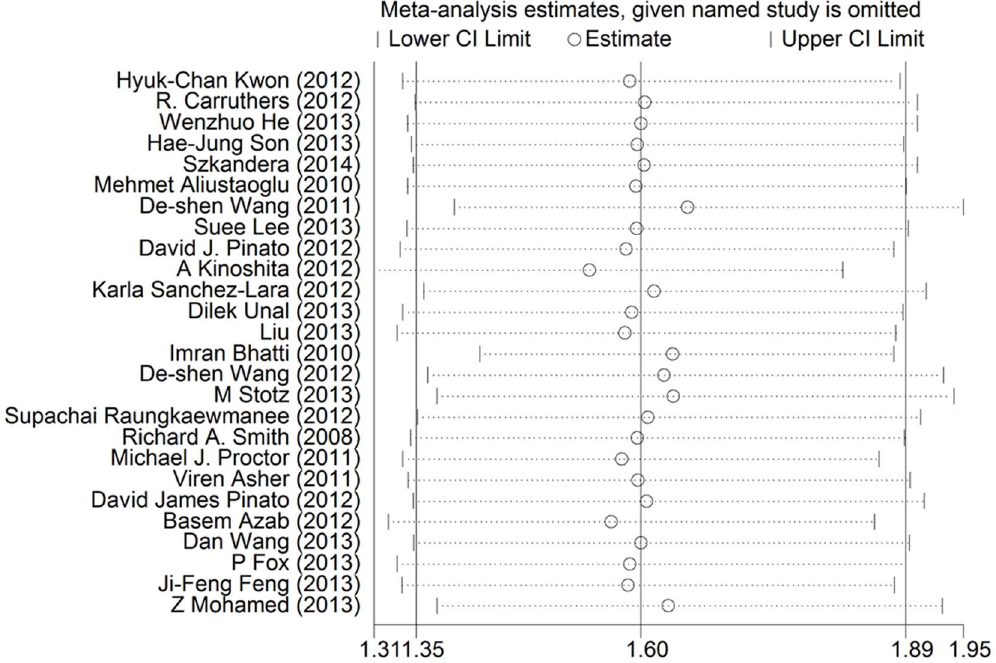
Figure 3. Effect of individual studies on the pooled HR for PLR and OS of patients. doi:10.1371/journal.pone.0101119.g003 PLOS ONE |